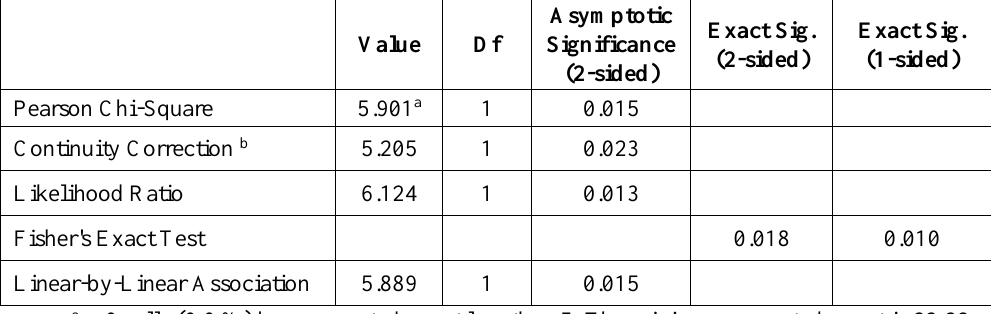
Table 3. Chi-square test results for independence between EB and OI ( n = 477) Asymptotic Exact Sig. Exact Sig. Value Df Significance (2-sided) (1-sided) (2-sided) Pearson Chi-Square 5.901 a 1 0.015 Continuity Correction b 5.205 0.023 Likelihood Ratio 6.124 0.013 Fisher's Exact Test 0.018 0.010 Linear-by-Linear Association